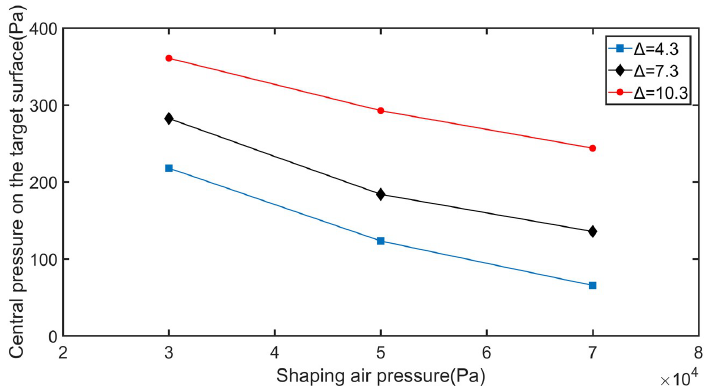
Figure 16. Pressure at the center of the target surface.